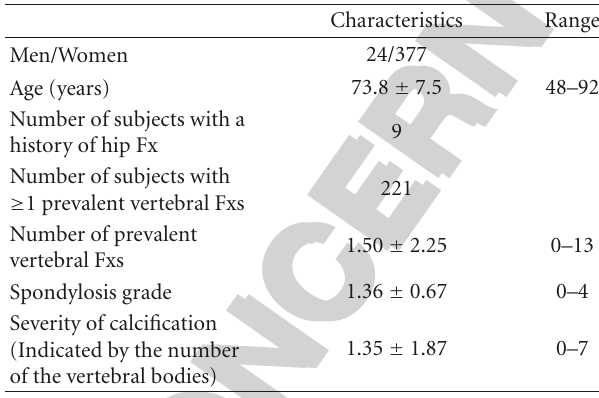
Table 1: Characteristics of the study